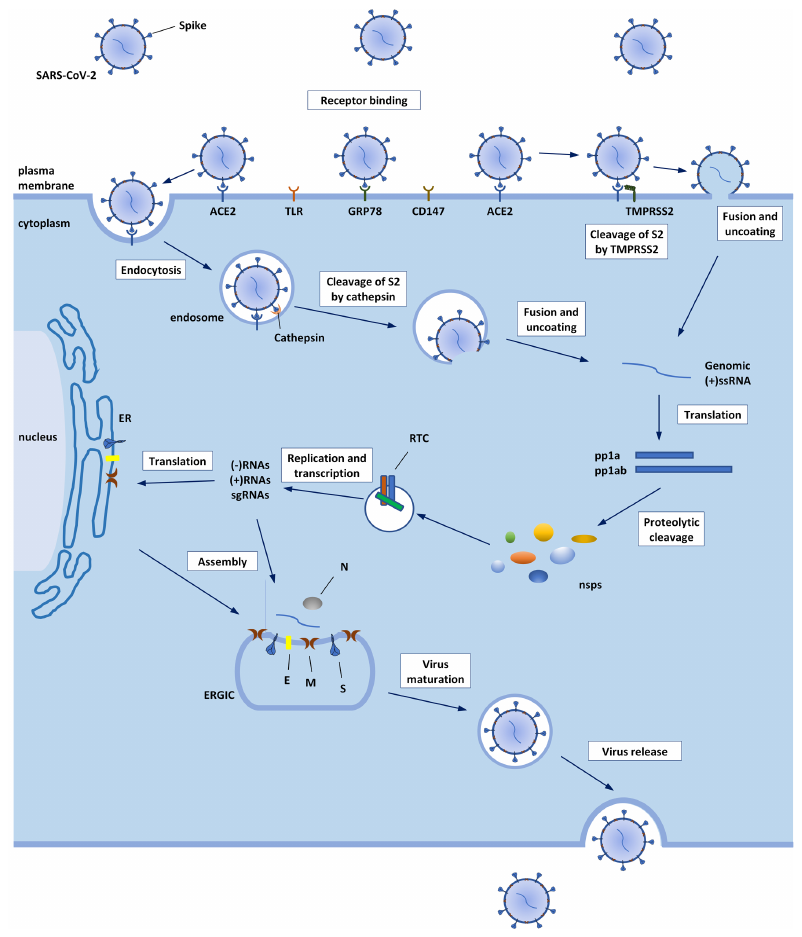
Figure 4. SARS-CoV-2 life cycle . SARS-CoV-2 entry into the host cell is mediated by the binding of the Spike protein (S) to ACE2. Then, entry requires S protein priming by the TMPRSS2, leading to S protein cleavage, which facilitates viral fusion with the membrane of the target cell. In case of low levels of TMPRSS2 on the target cell, the virus is internalized via endocytosis and, after endosomal acidification, S2 is cleaved by the enzymes cathepsins. Then, regardless of which of the two mechanisms was followed, the viral RNA is released into the cytoplasm of the host cell. Emerging evidence supports interactions between S protein and other host receptors and proteins (such as GRP78, CD147, TLRs), apart from ACE2, that may represent alternative routes for viral entry. After the release of viral (+)ssRNA genome into the cytoplasm, pp1a and pp1ab are produced by cellular ribosomes and then processed by viral proteases (PLpro and 3CLpro) into 16 nsps that form the replicase–transcriptase complex (RTC). The RTC mediates the synthesis of (-)RNA. A full- length (-)RNA copy serves as a template for the full-length (+)ssRNA genome, whereas sgRNAs are translated into structural (S, M, E, N) and accessory proteins. The viral nucleocapsid is assembled from newly synthesized viral genomic (+)ssRNA and N proteins in the cytoplasm, and then buds into the ER–Golgi intermediate cavity (ERGIC) reaching the S, E, and M for viral assembly. The new virions are then released from the cells via